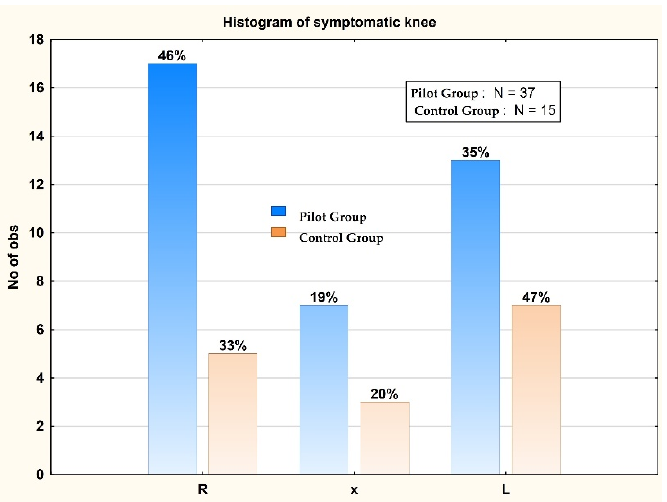
Figure 4. Histogram representation for the affected knee distribution of the control group (CG) and the pilot group (PG).